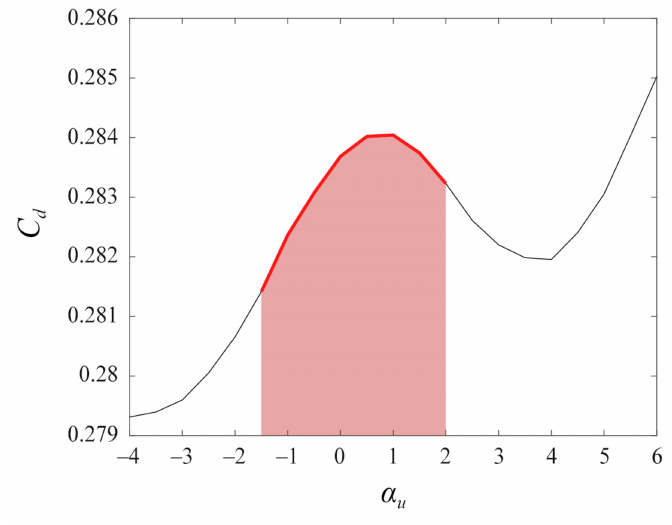
Figure 14. The e ff ect of α u ∈ 1 ± 5 on C d when γ u = α v = γ v = 1. When α u and γ u are taken as variables, the value surface of C d with α u , γ u ∈ 1 ± 5 is displayed in Figure 15. The ranges of α u and γ u that meet the curvature requirements are [ − 1.5, 2] and [ − 1.5, 2.5], respectively. There are 64 parameter sets suitable for CFD simulation in these ranges, since some parameter sets at the limit (e.g., α u = − 1.5 and γ u = − 1.5) do not meet the requirements. It could be concluded that C d takes the optimal value 27.85% when α u = − 1 and γ u = − 1.5.